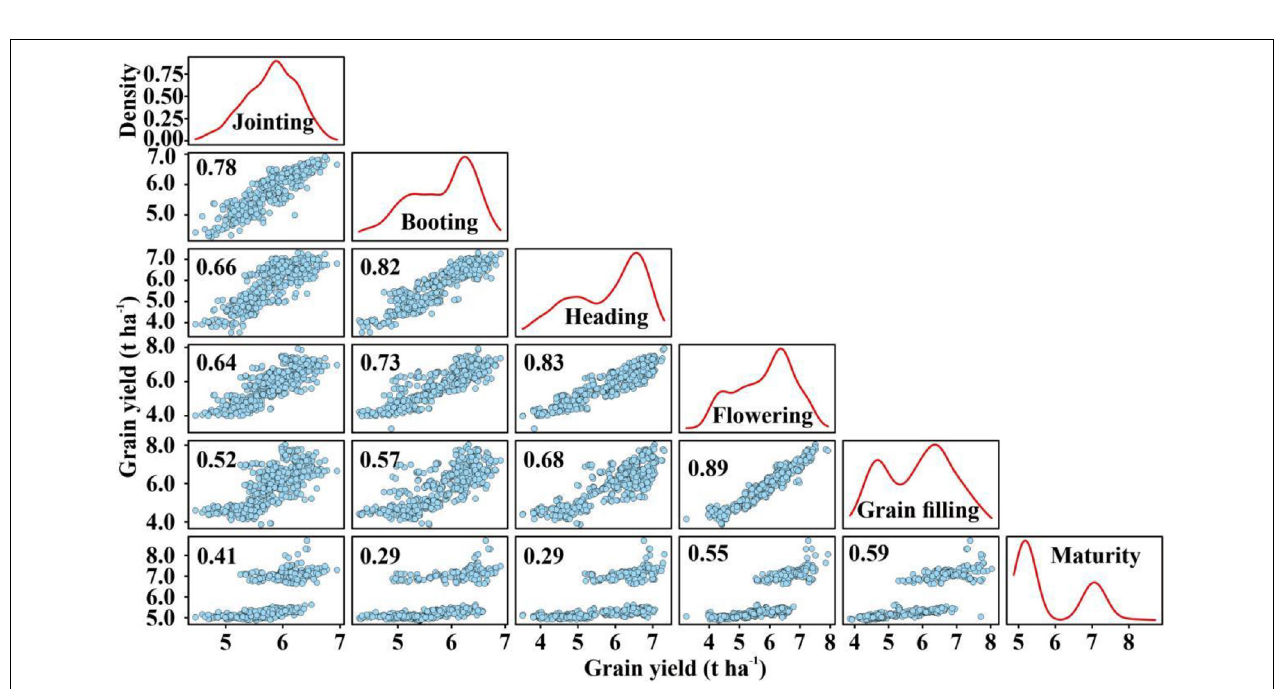
FIGURE 7 | Regression plots, density curve, and R 2 -values between predicted GY in six developmental stages.